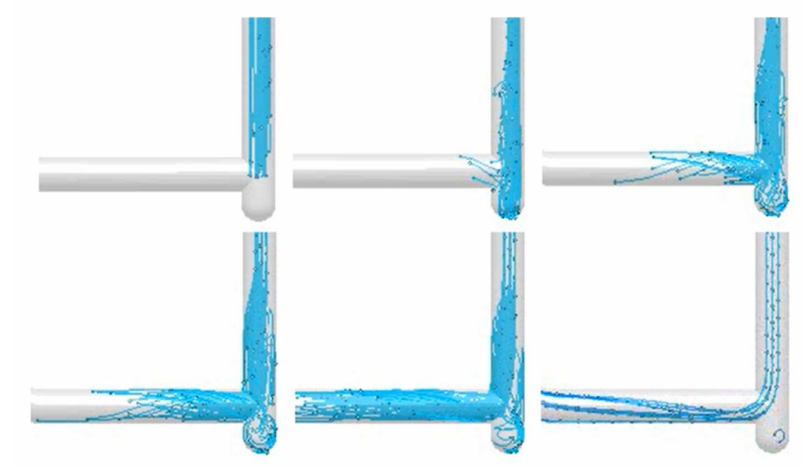
Figure 24. Flow tracer in the sprue well (S s 4),